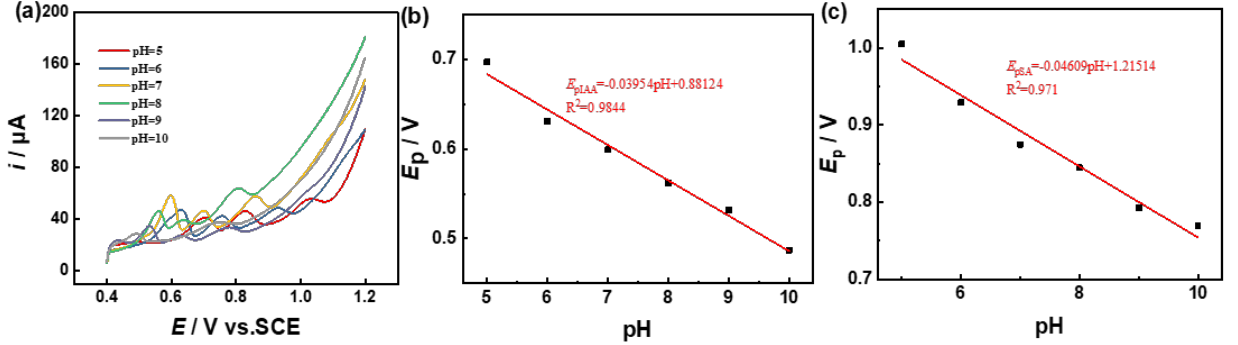
Figure 7. ( a ) LSV curves of PPRONPs − CDs − MWCNTs/GCE in PBS containing 50 μM IAA and 50 μM SA at different pH values. Scan rate is 100 mV/s. ( b ) The linear correlation of E p of IAA vs. Ph. ( c ) The linear correlation of E p of SA vs. pH.